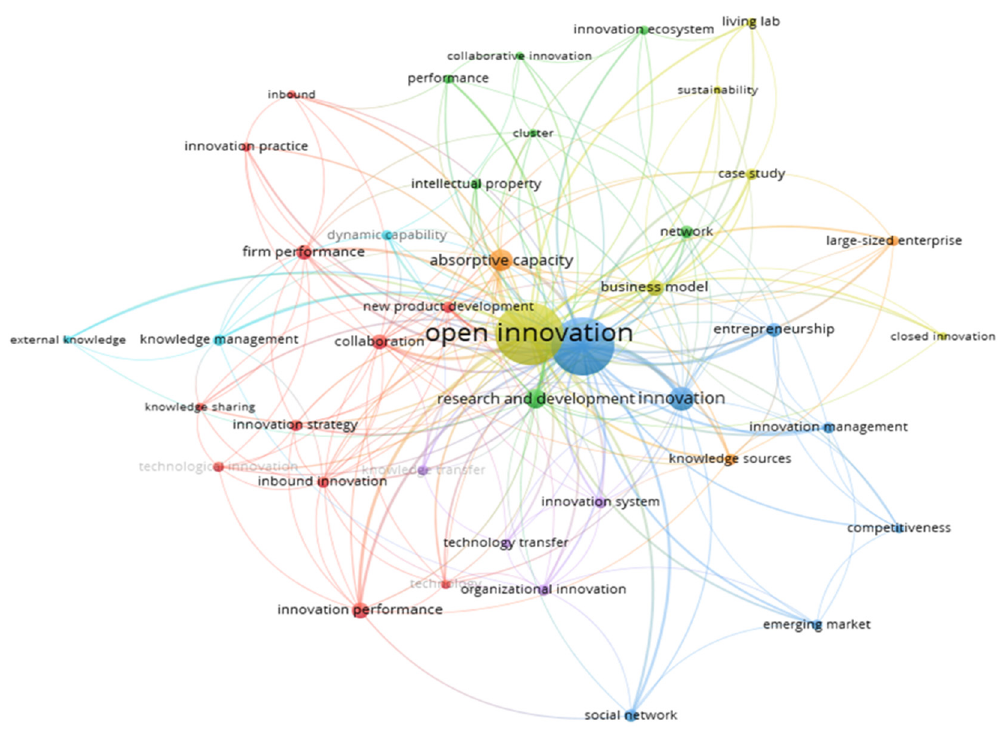
Figure 4. Visualization of co-occurrence author keyword network.